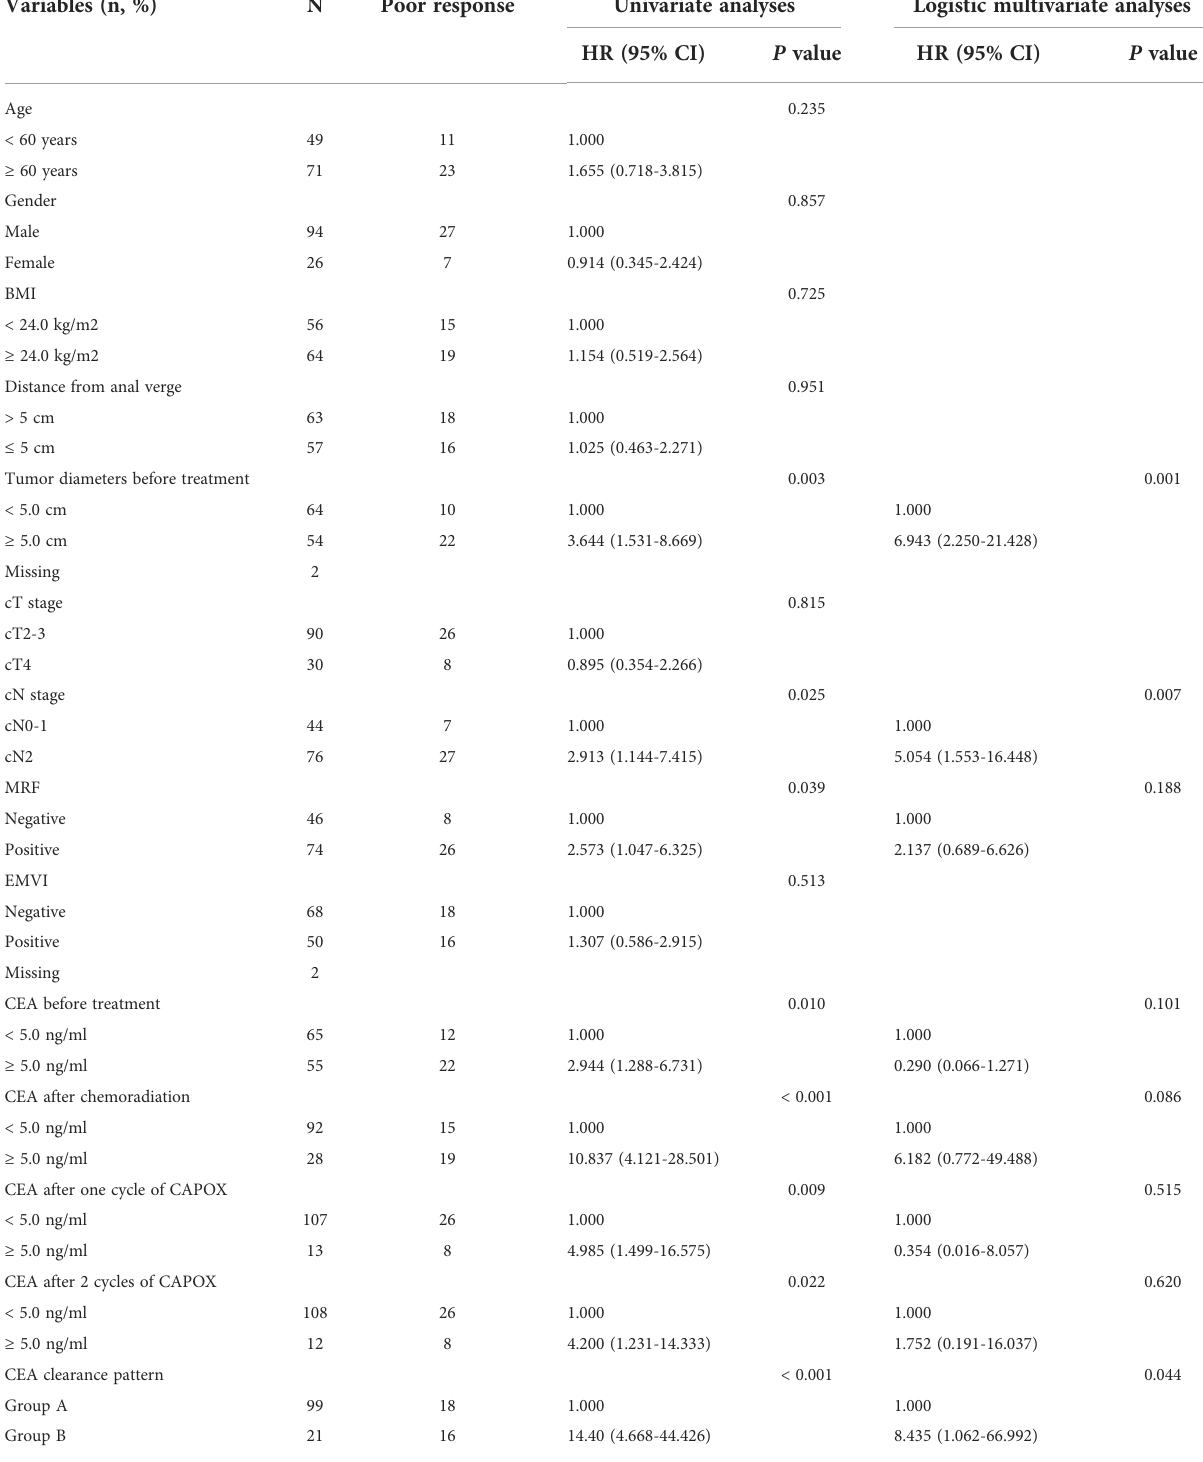
TABLE 4 Univariate and logistic multivariate analyses for predicting tumor regression response of patients with locally advanced rectal cancer following total neoadjuvant